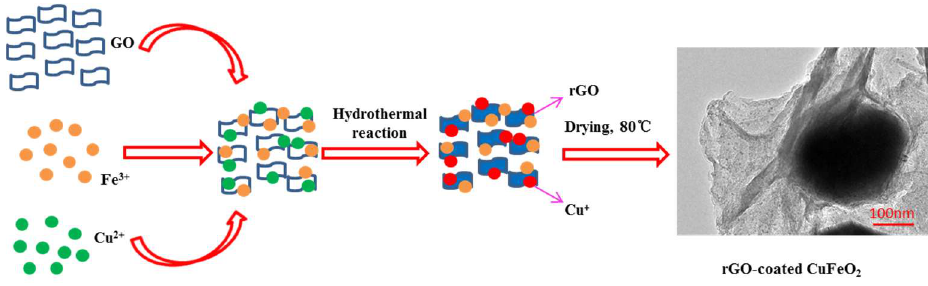
Figure 1. The formation mechanism of the rGO-coated CuFeO 2.